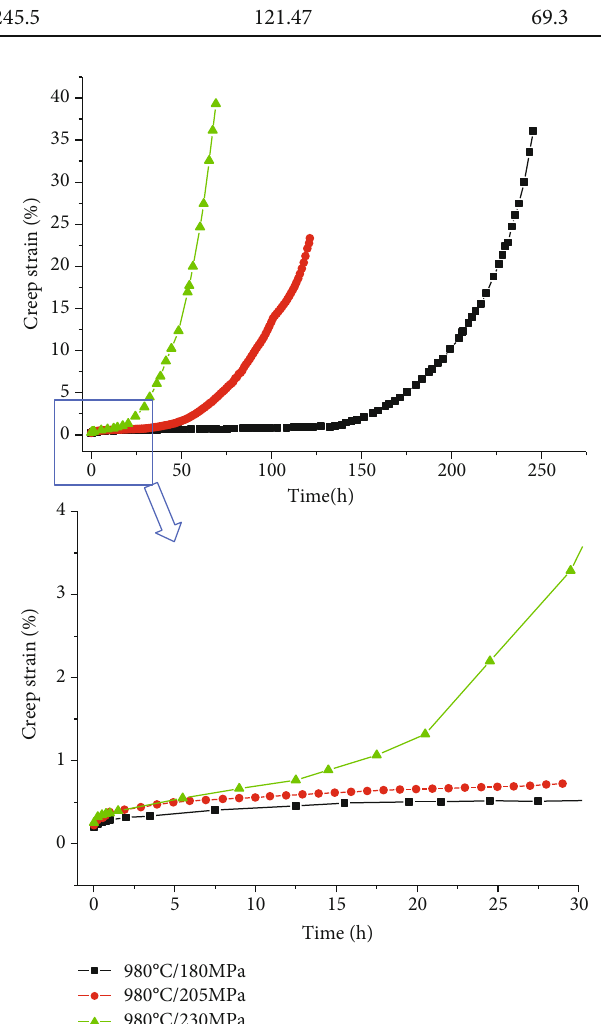
Figure 1: Creep curve of single crystal alloy IC6SX at 980 °